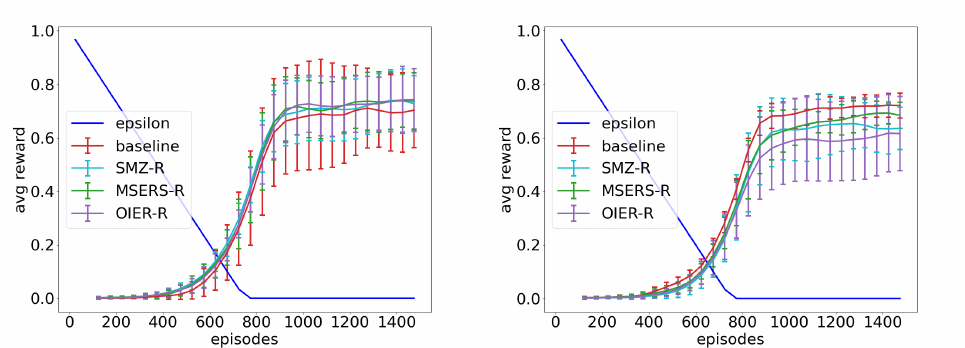
Figure A4. The results for the IER mode: R and t expl = 750. state encoding: VE. state encoding: CE.